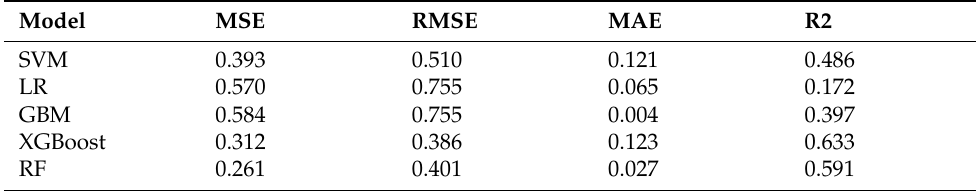
Table 3. LoS prediction performance of various models.